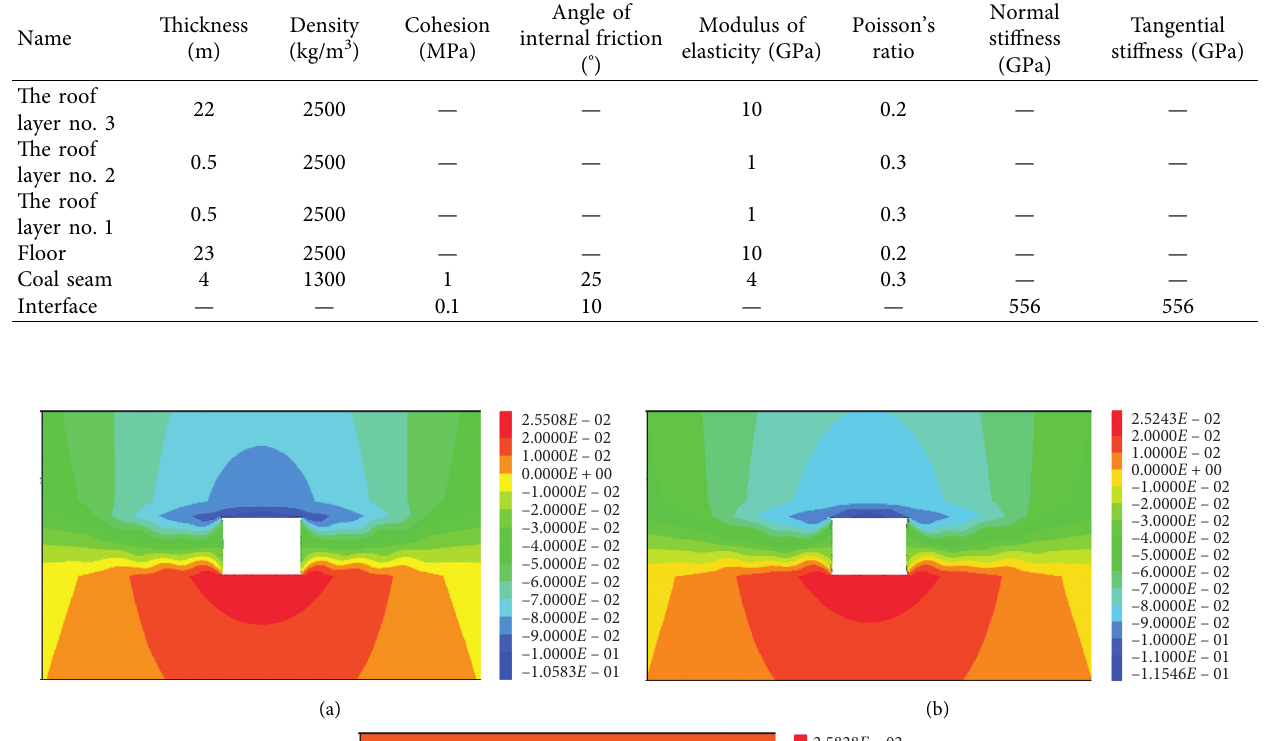
Table 1: Properties of surrounding rock and interface considering compressive bar stability.